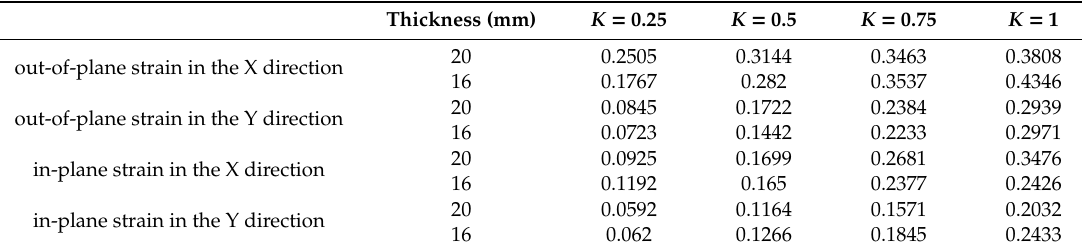
Table 3. Maximum relative variation.